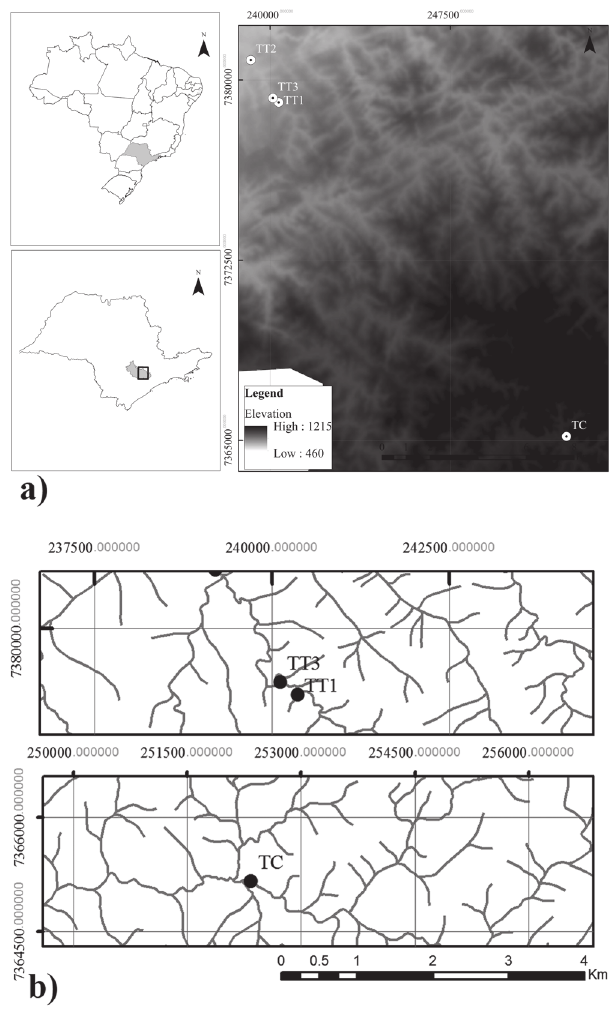
Fig. 1. Map of the study area showing São Paulo State within Brazil (top left panel); Sorocaba River basin (shaded) and sample region (square) within São Paulo State (bottom left panel); and elevation profile and hydrography with position of the sampled sites (circles) in the sample region (right